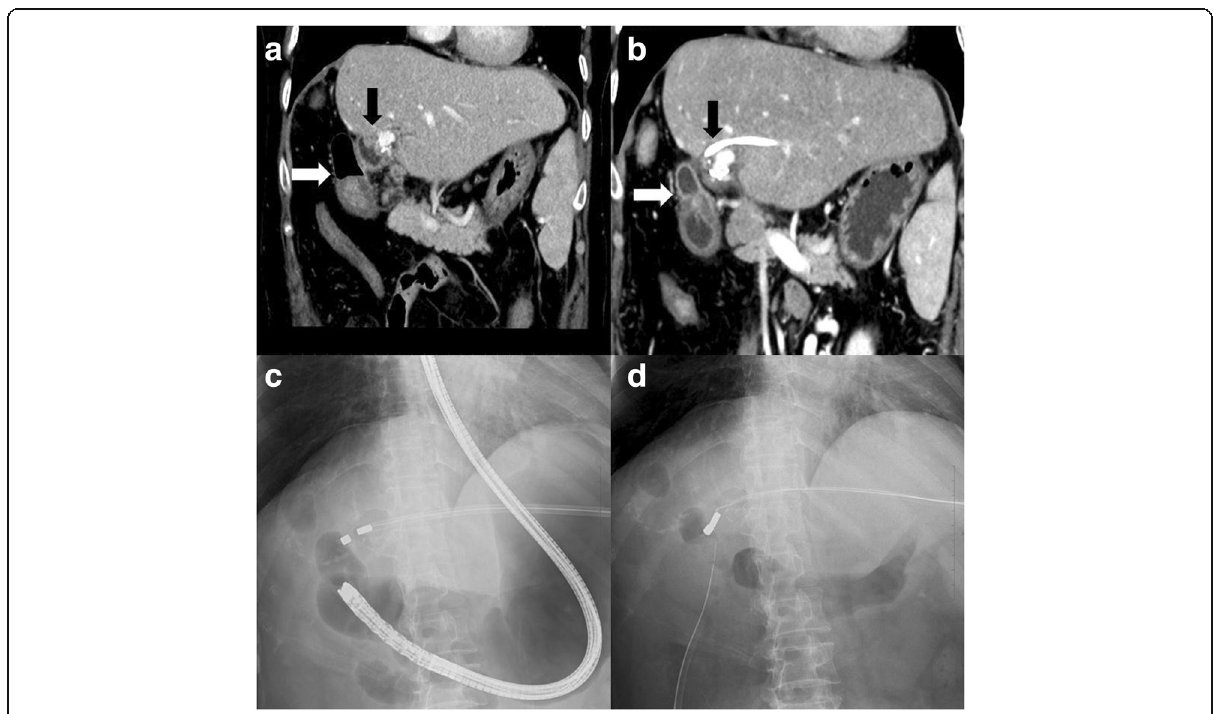
Fig. 2 a Computed tomography showed the bulbus duodeni ( white arrow ) and biliary duct ( black arrow ) come in contact with each other. b PTBD tube was placed into B3. c The parent magnet was inserted from PTBD tube, and daughter magnet was placed by gastrointestinal endoscopy. d The parent and daughter magnets connected sandwiching the biliary wall and duodenal